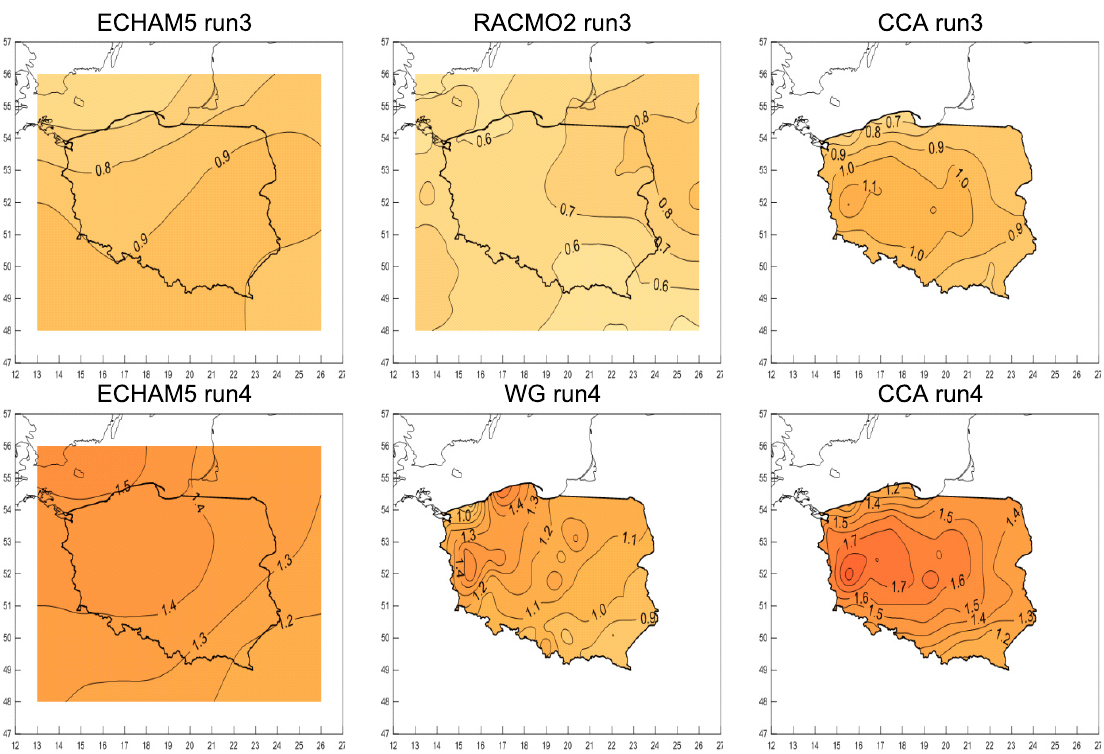
Fig. 7. Anomalies of air temperature (°C) in the summer season (JJA) 2011–2030 in relation to reference period (1971–2000) in Poland based on A1B emission scenario for models: ECHAM5 run 3and 4, RACMO2 run 3, CCA run 3 and 4, WG run 4.